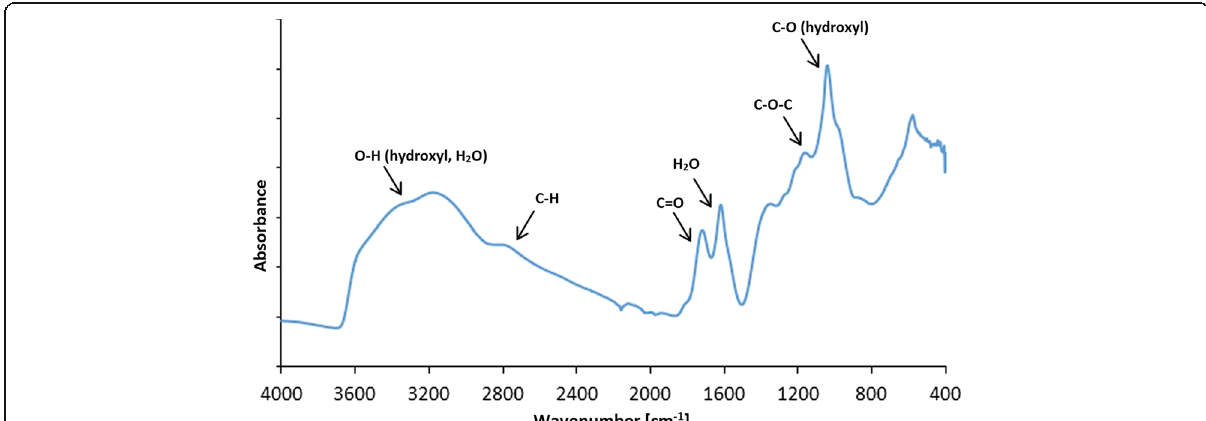
Fig. 3 FT-IR (ATR, attenuated total reflectance) spectrum of graphene oxide with proposed assignment of functional groups present in GO. The most notable peaks were observed at ~3500 cm − 1 , (attributed to water and hydroxyl groups), ~1080 cm − 1 (hydroxyl groups), ~1600 cm − 1 (assigned to C=C bonds present in graphitic carbon). Other peaks observed on the FT-IR spectrum show that GO is rich in groups containing C=O (mainly carboxyl groups), peak around 1720 cm − 1 , epoxy (C – O – C) with the visible peak around 1200 cm − 1 , and C – H bonds (peak around 2800 cm − 1 )